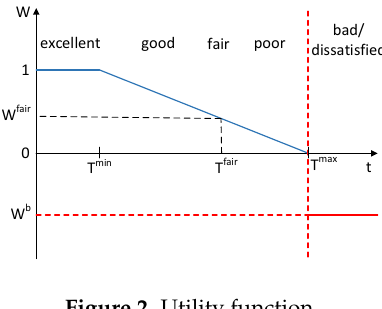
Figure 2. Utility